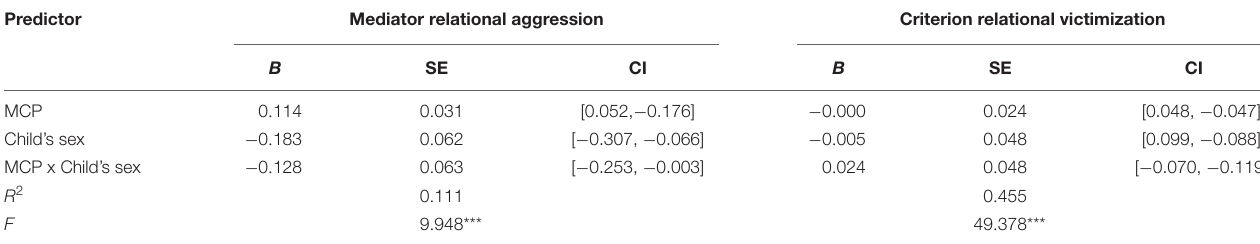
TABLE 5 | Moderated mediation models for mother’s corporal punishment, child’s relational aggression, relational victimization, and sex. Predictor